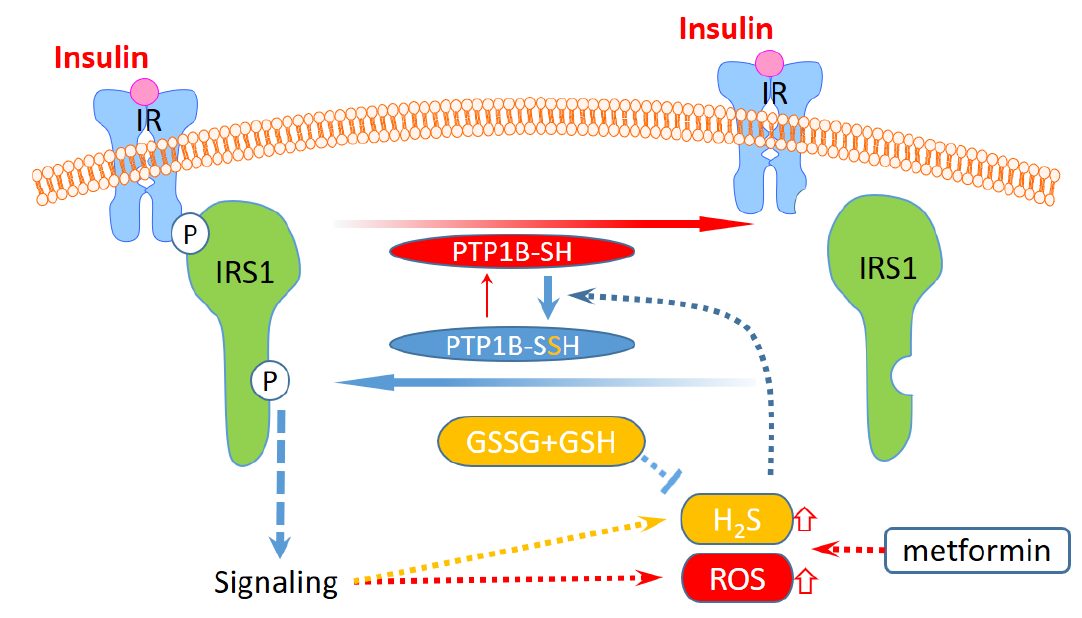
Figure 7. A putative model of differential regulation for insulin signaling in different types of cells via ROS/H 2 S mediated PTP1B S-sulfhydration. The level of H 2 S and ROS could increase in response to insulin signaling, and the increases could be enhanced by metformin and may be suppressed under a high level of glutathione. The increases in H 2 S and ROS can further induce PTP1B S-sulfhydration to suppress this activity by removing the phosphorylation from IRS1. IR: insulin receptor; IRS1: insulin receptor substrate 1.